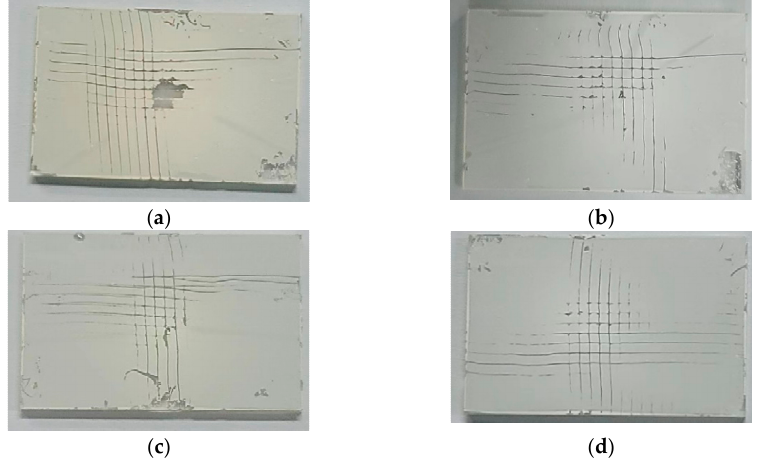
Figure 8. The cross-cut testing results of four samples, namely ( a ) without the annealing and DMF dose, ( b ) with 350 °C annealing, ( c ) with preparation of 7.5 wt% DMF dose, and ( d ) with the 350 °C annealing and 7.5 wt% DMF dose.